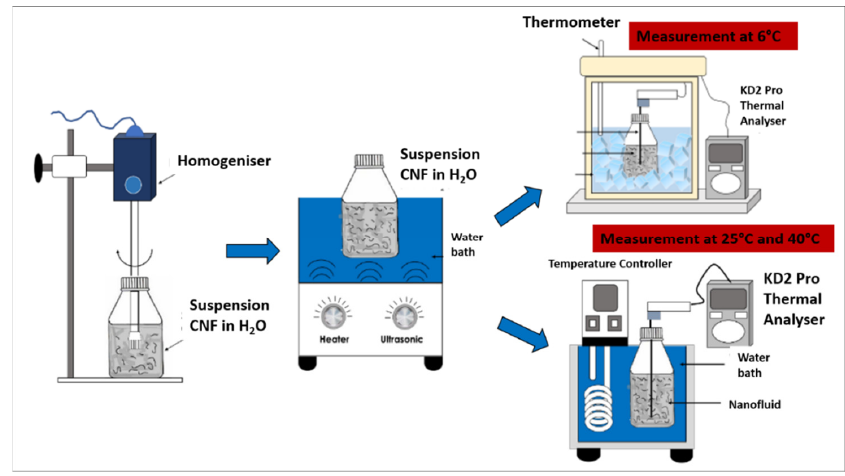
Figure 2. Process flow diagram for the preparation and evaluation of the surface-oxidised CNF- based nanofluids.